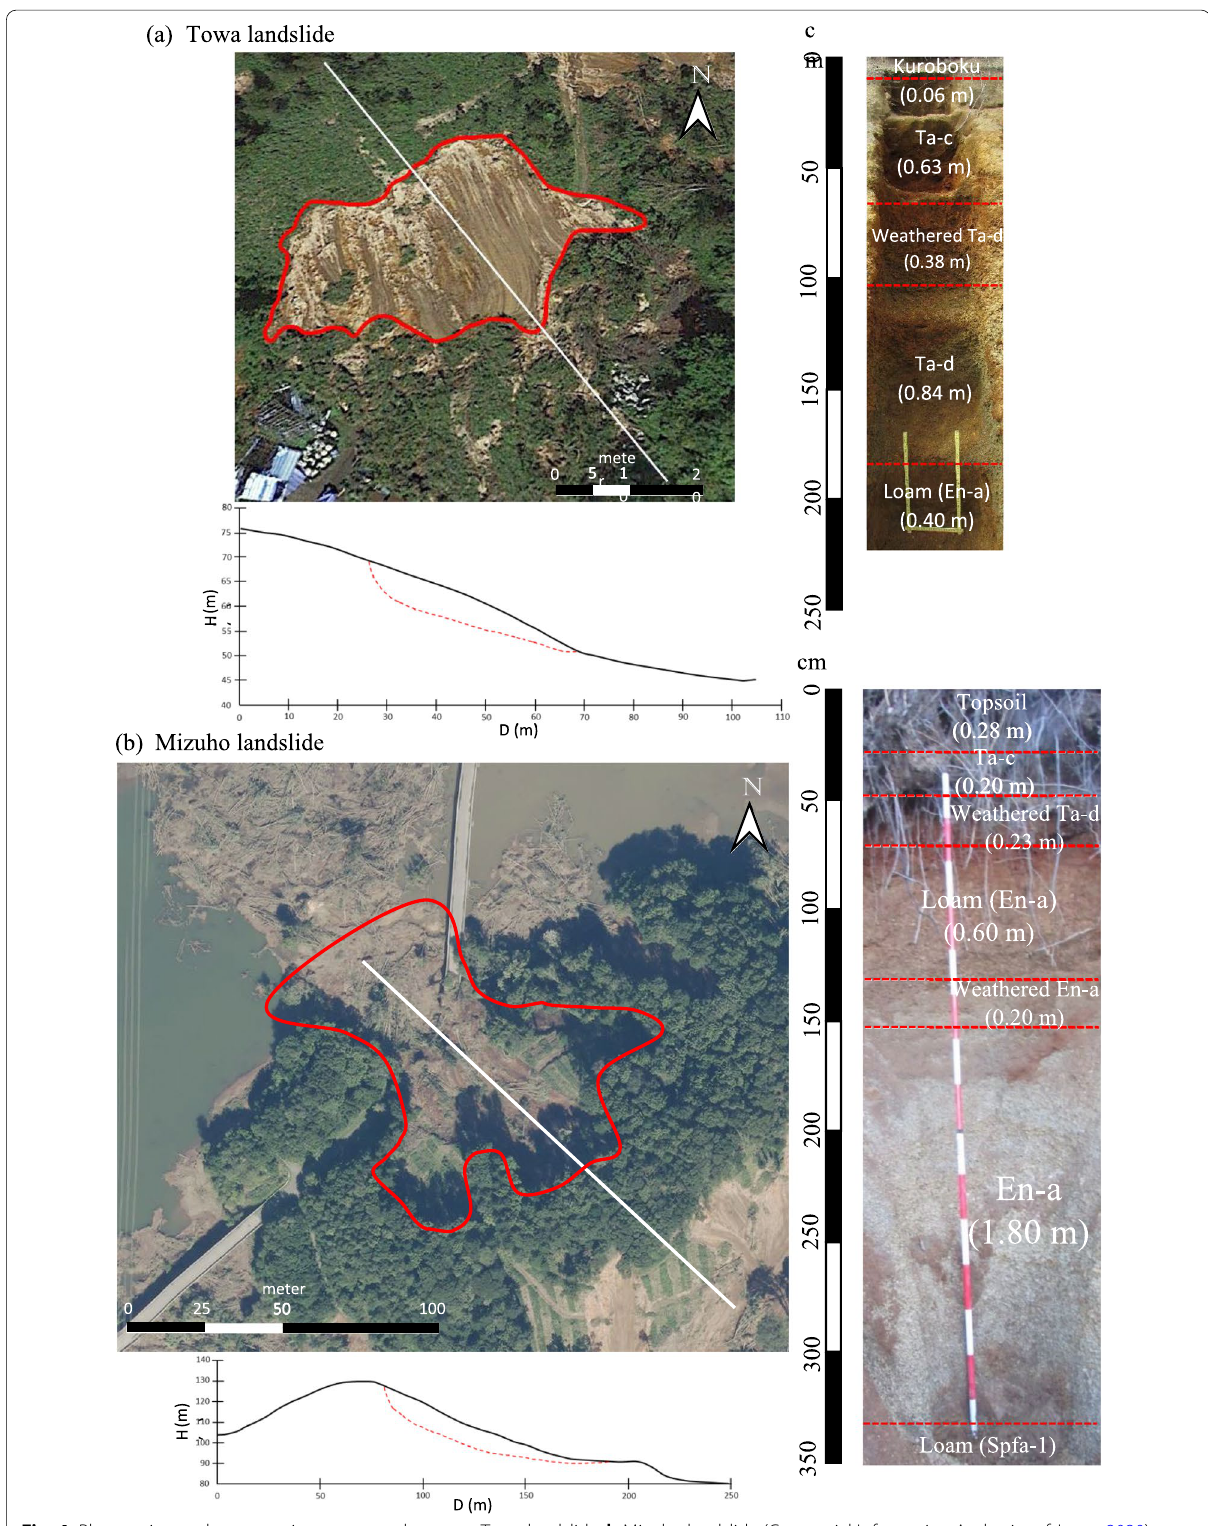
Fig. 4 Plan section and cross section on research areas; a Towa landslide, b Mizuho landslide (Geospatial Information Authority of Japan